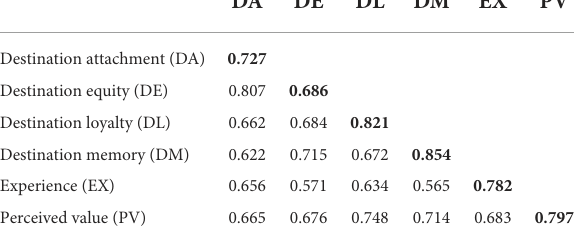
TABLE 3 The discriminant